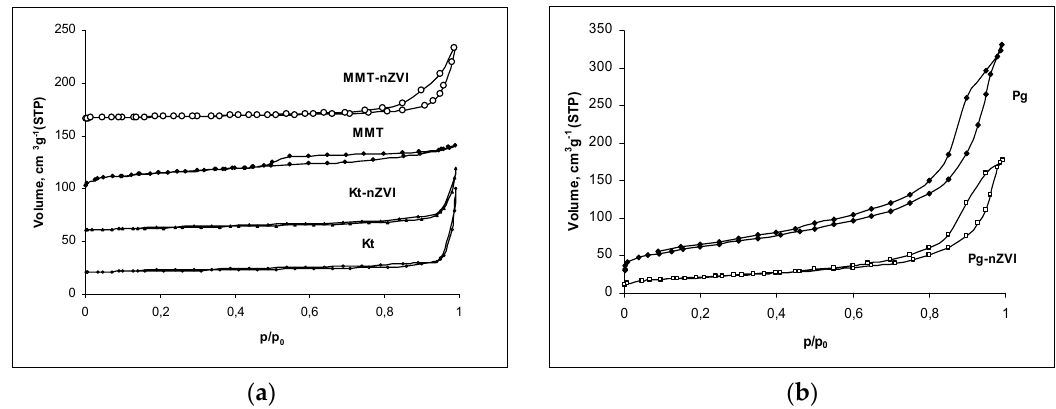
Figure 2. Nitrogen adsorption–desorption isotherms of pristine and nZVI—modified clay minerals: ( a )—kaolinite and montmorillonite,( b )—palygorskite.